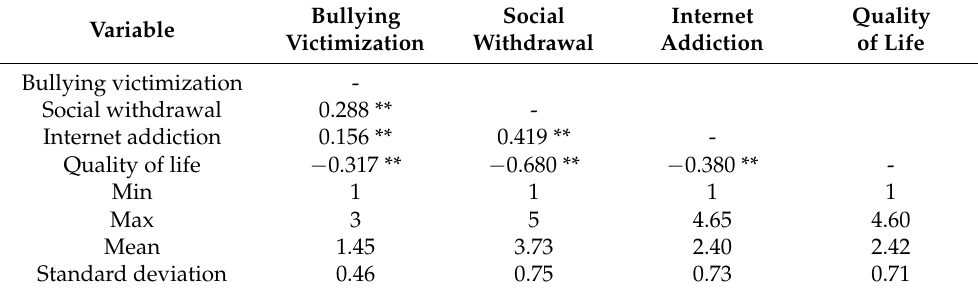
Table 2. Descriptive statistics and correlations among main